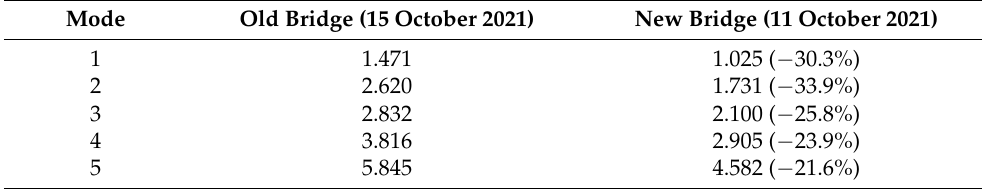
Table 4. Comparison of the natural